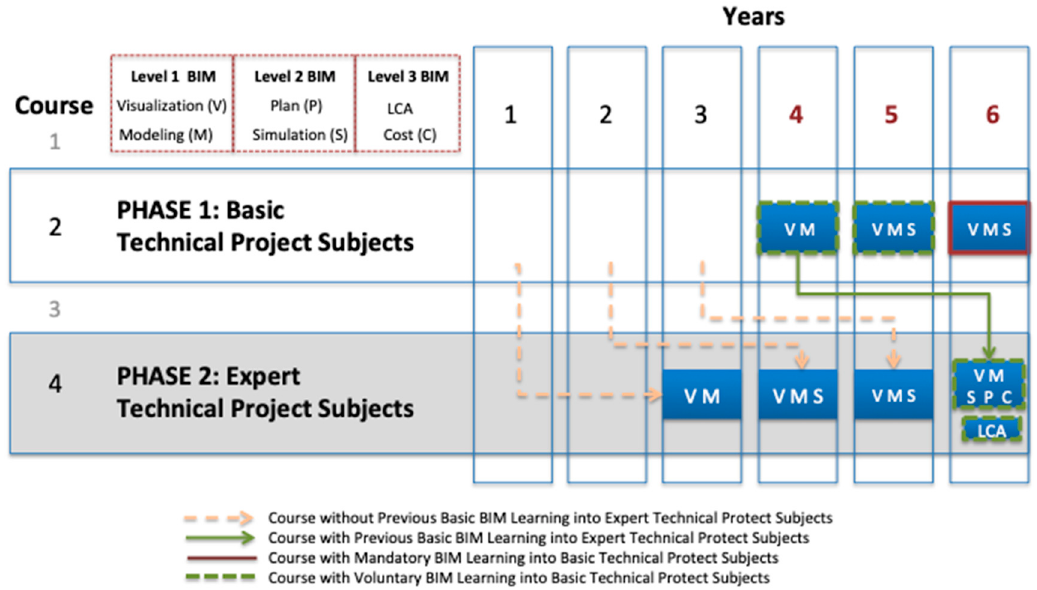
Figure 1. Flow chart for the building information modeling (BIM) implementation for a technical project course.